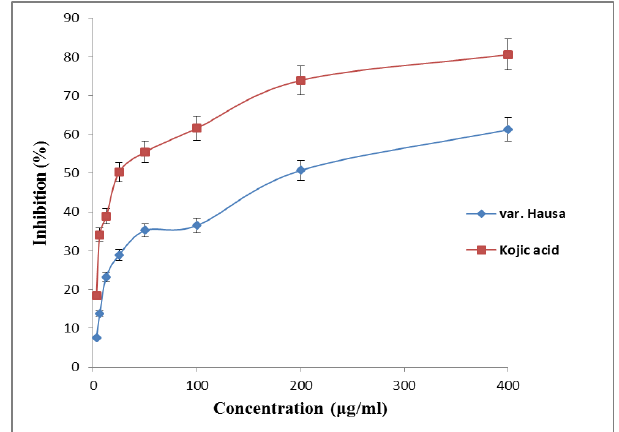
Figure 3 : The percentage inhibition curve of L. esculentum Mill. (var. Hausa) and kojic